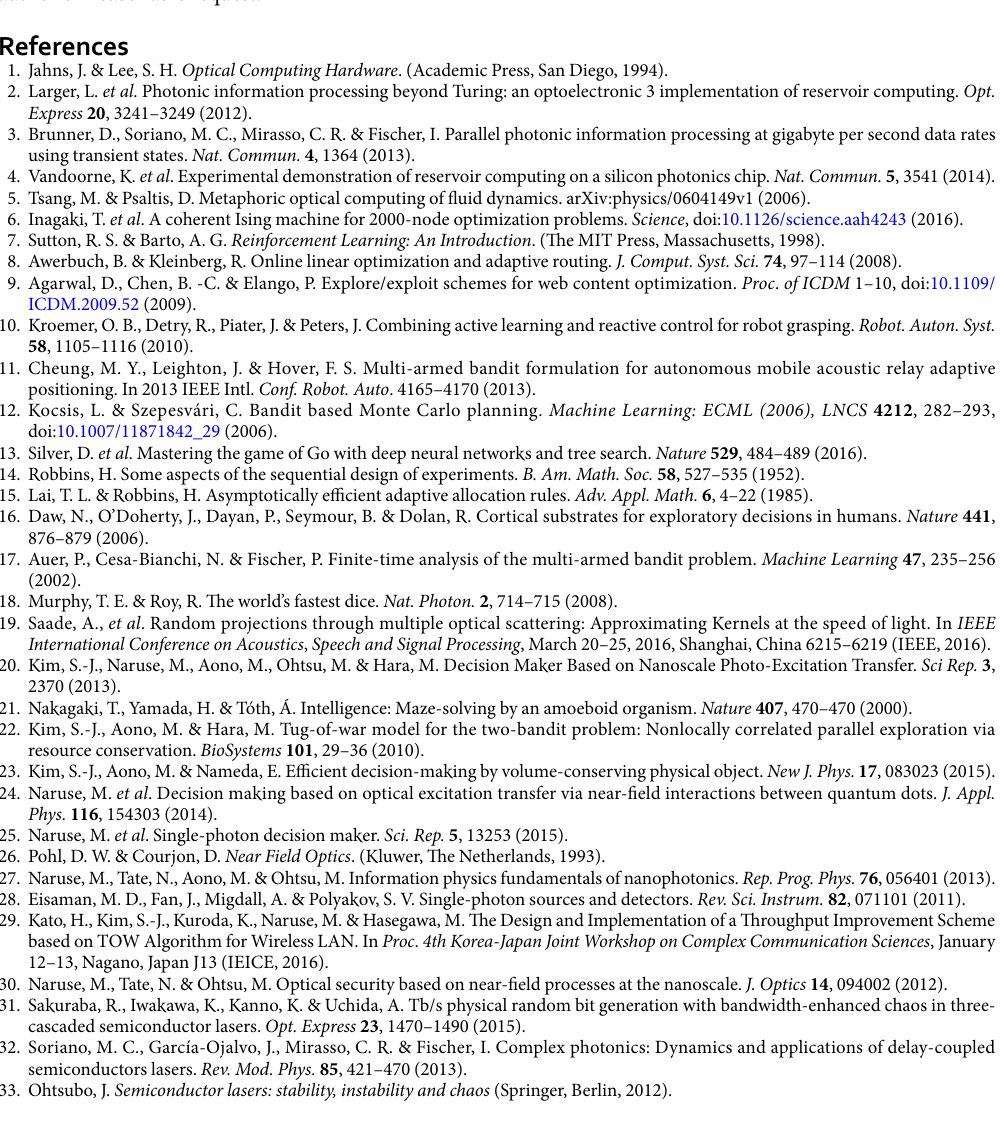
Fig. 3c was evaluated as the average of these 120 kinds of autocorrelations. The autocorrelation of quasipe- riodic signals was evaluated in the same manner. (5) Coloured noise : Coloured noise was calculated on the basis of the Ornstein–Uhlenbeck process using white Gaussian noise and a low-pass filter in numerical simulations 43 . We assumed that the coloured noise was generated at the sampling rate of 100 GHz, and the cut-off frequency of the low-pass filter was set to 10 GHz (the correlation time was 100 ps). Forty sequences of 10,000,000 points were generated. The methods of calculating CDR and autocorrelation were the same as that with ( 2 ), ( 3 ), and ( 4 ) whereas the number of sequences was 40 (not 120). The reduction in the number of sequences was due to the excessive computational costs in our computing environment. (6) Surrogate methods : The surrogate time series of original chaotic sequences were generated by the rand- perm function in MATLAB which is based on the sorting of pseudorandom numbers generated by the Mersenne Twister. Data